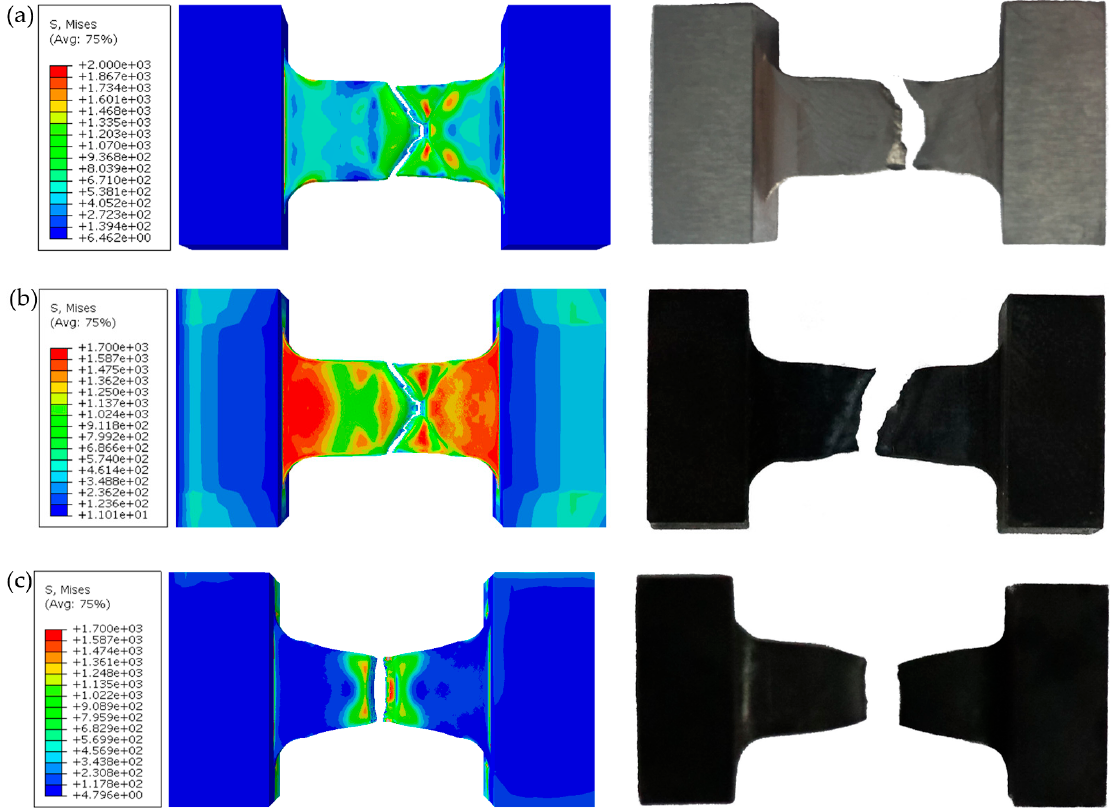
Figure 11. Fracture morphology in SHTB test and simulation at ( a ) 25 °C; ( b ) 600 °C; and ( c ) 900 °C.